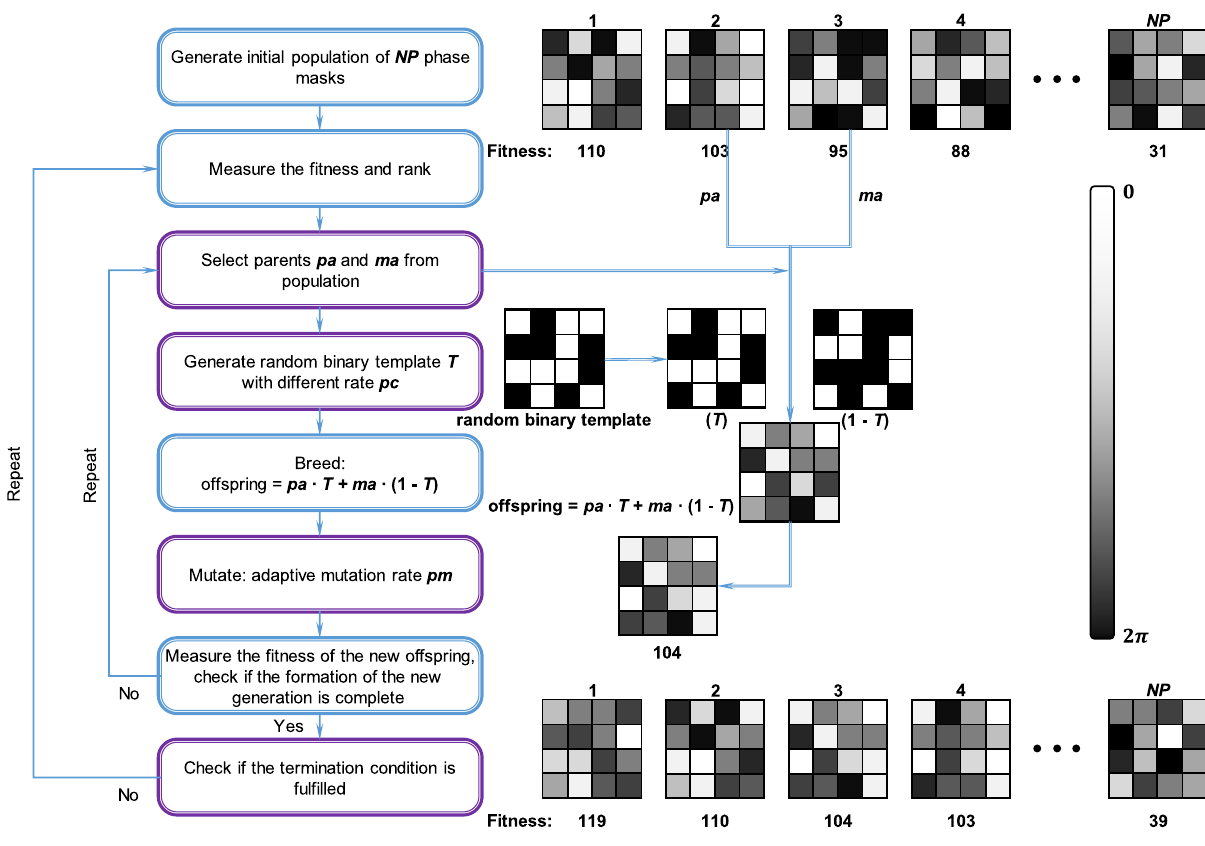
Fig. 1. Flowchart of the